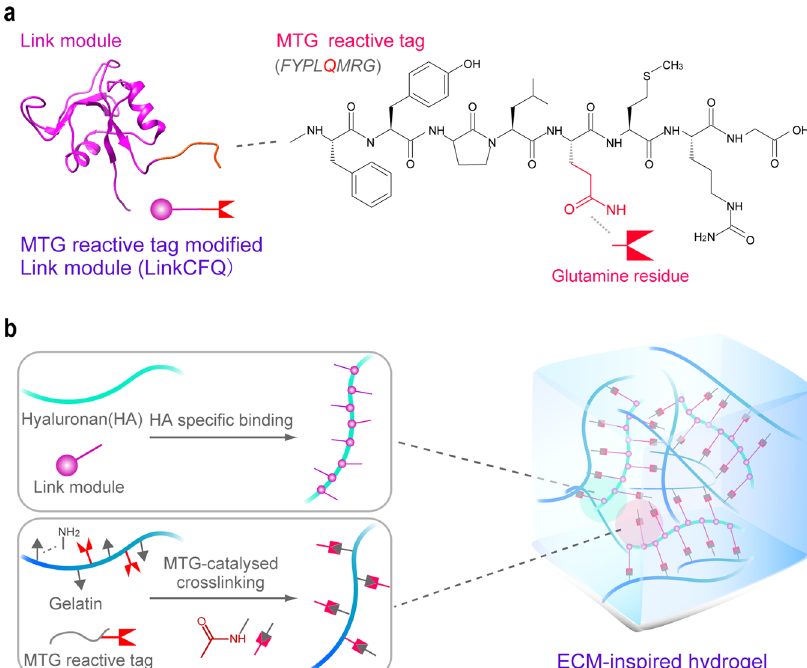
Fig. 7 Schematic illustration of LinkCFQ and ECM-inspired hydrogel. a Structure of the genetically engineered Link module (LinkCFQ) was predicted via the MODELLER software using Link_TSG6 (PDB ID: 1O7c) 65 as the template. LinkCFQ was designed with a C-terminal extension using the MTG-reactive tag (FYPLQMRG) in the Link module. b ECM-inspired hydrogel fabricated with LinkCFQ using HA and gelatin through the incorporation of the natural HA/ Link module interaction and formation of the MTG-catalyzed isopeptide bond. Glutamine and lysine residues are illustrated using red and gray graphics,